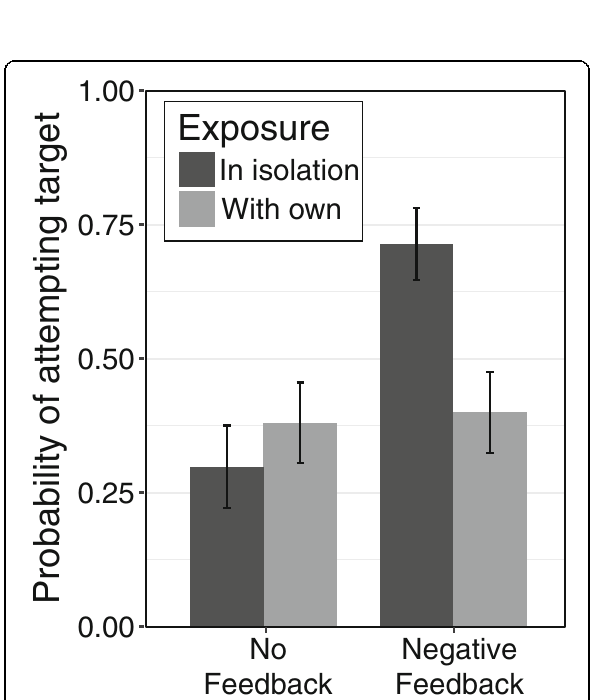
Fig. 7 The probability of adopting the target strategy in the no feedback and negative feedback conditions, when it was presented in isolation vs with participants' own current strategy. Error bars display standard